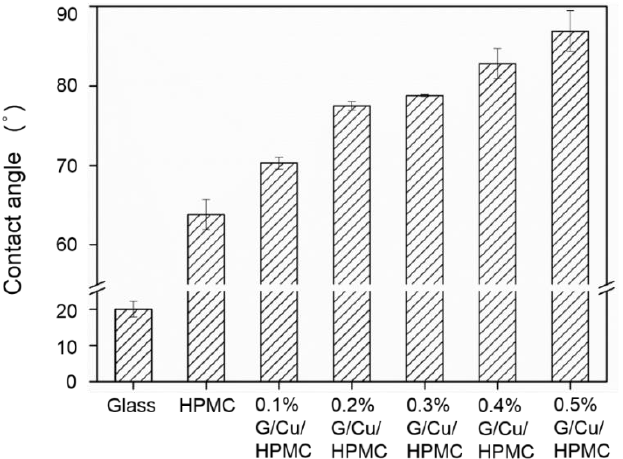
Figure 5. Water contact angle of composite coatings.